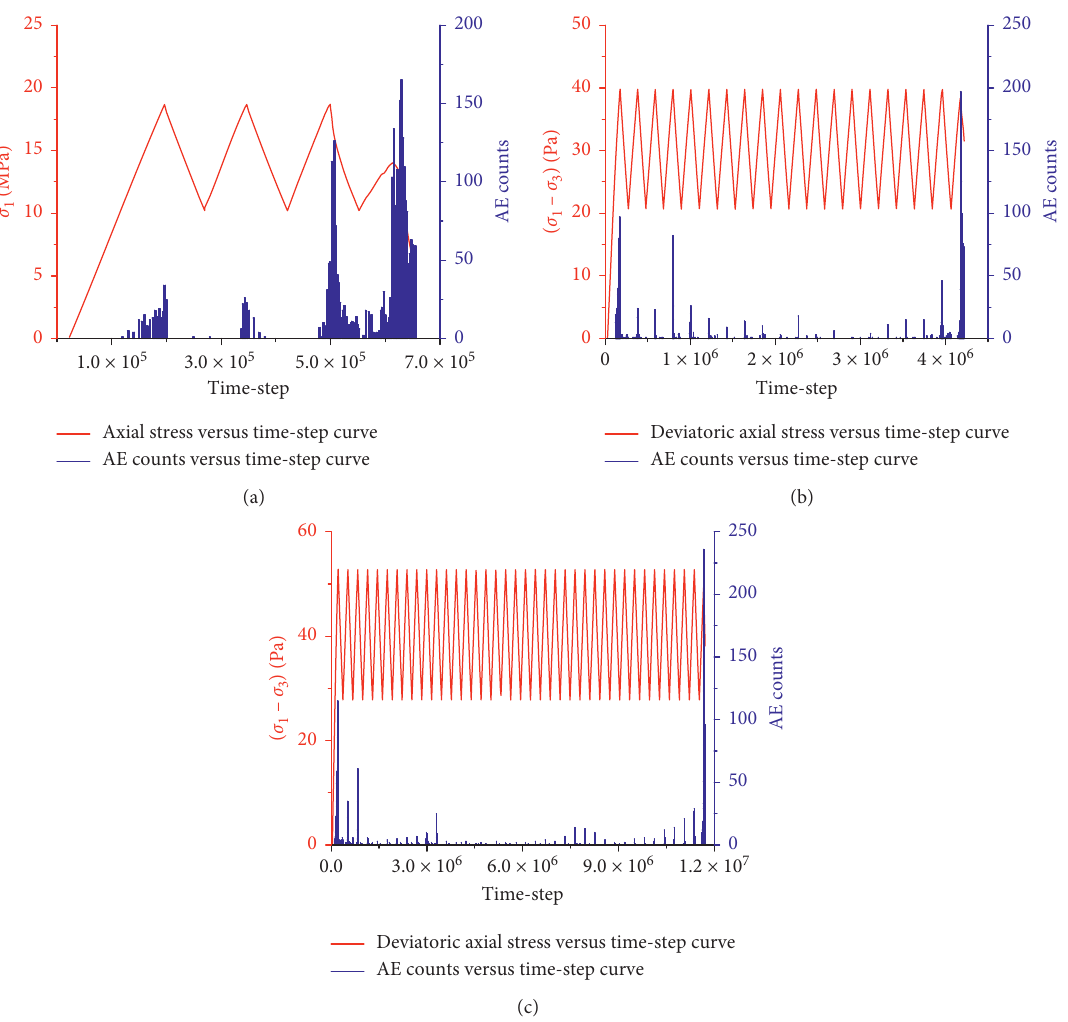
Figure 5: AE counts and axial stress versus time-step curves under different confining pressures: (a) 0MPa, (b) 5 MPa, and (c)